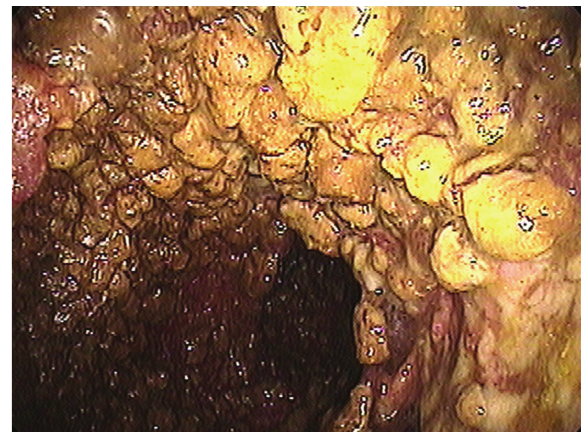
Figure 2: Pseudomembranes and pneumatosis coli. Endoscopic evaluation of the colonic mucosa reveals pseudomembranes. Cystic lesions are evident beneath the pseudomembranous layer.